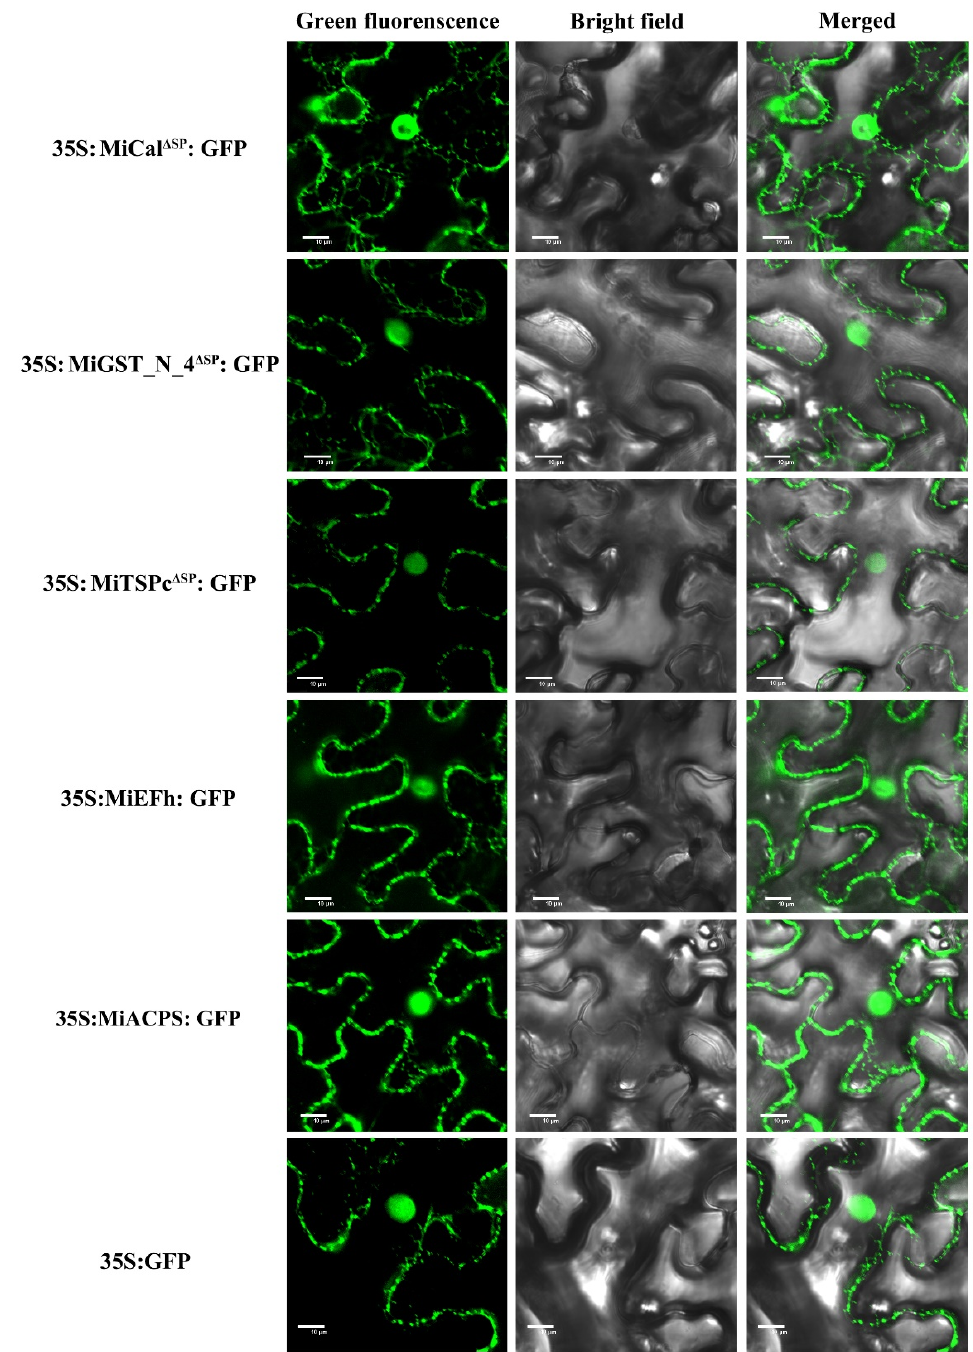
Figure 3. Subcellular localization of the five effectors when expressed in plant cells. Agrobacterium culture harboring the 35S: MiCal Δ SP : GFP, 35S: MiGST_N_4 Δ SP : GFP, 35S: MiTSPc Δ SP : GFP, 35S: MiEFh: GFP, and 35S: MiACPS: GFP construct were hand-injected into WT Nicotiana benthamiana leaves at an inoculum of OD 600 = 1. Epidermal leaf tissues were collected and subjected to microscopy with a confocal laser scanning microscope post infiltration 48 h. The experiment was conducted three times with similar results. Scale bars, 10 μ m.